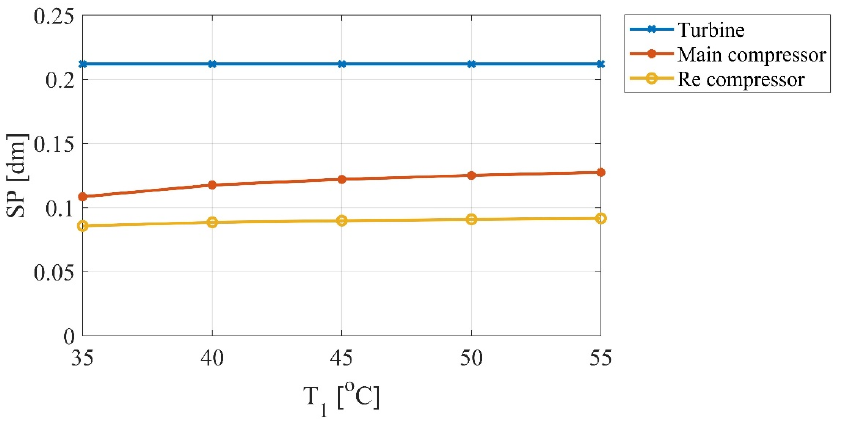
Figure 15. Size parameter ( SP ) vs. compressor inlet temperature ( T 1 ).